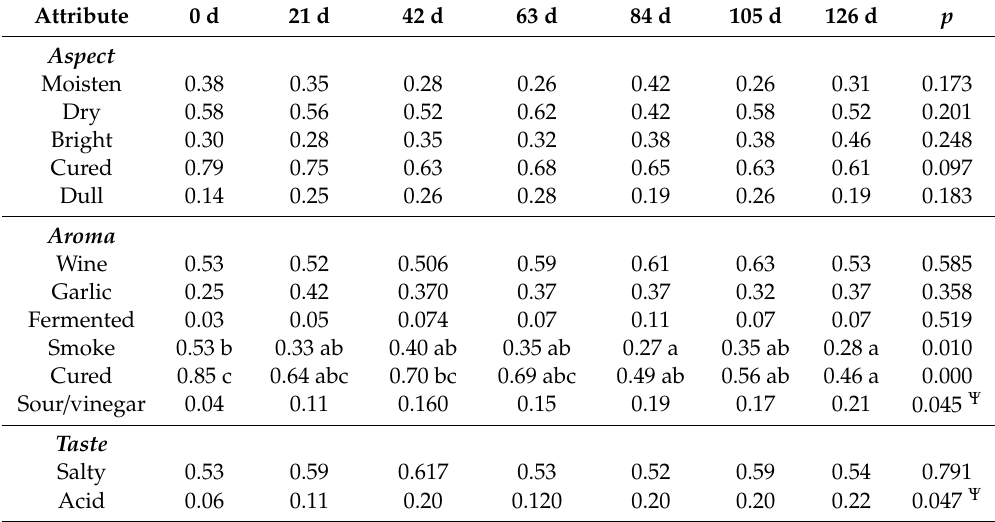
Table 2. Proportion of participants identifying each attribute of sliced cured loins with di ff erent storage